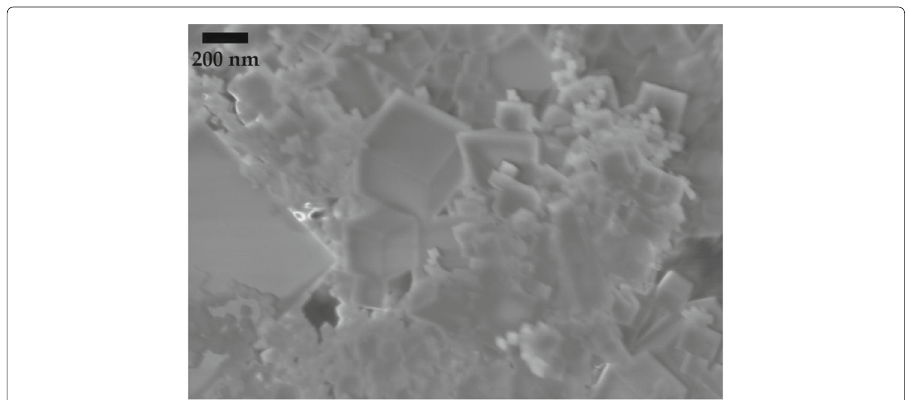
Fig. 6 A scanning electron microscopy (SEM) image of MgO smoke nanocrystals taken by a Karl Zeiss XB1540 microscope with a 3 keV electron beam. The large variation in the edge lengths of the cubic crystals, (10-1000 nm [37]) is visible